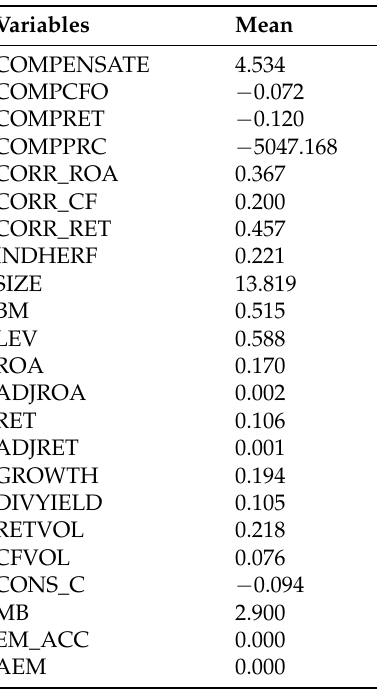
Table 1. Descriptive statistics of